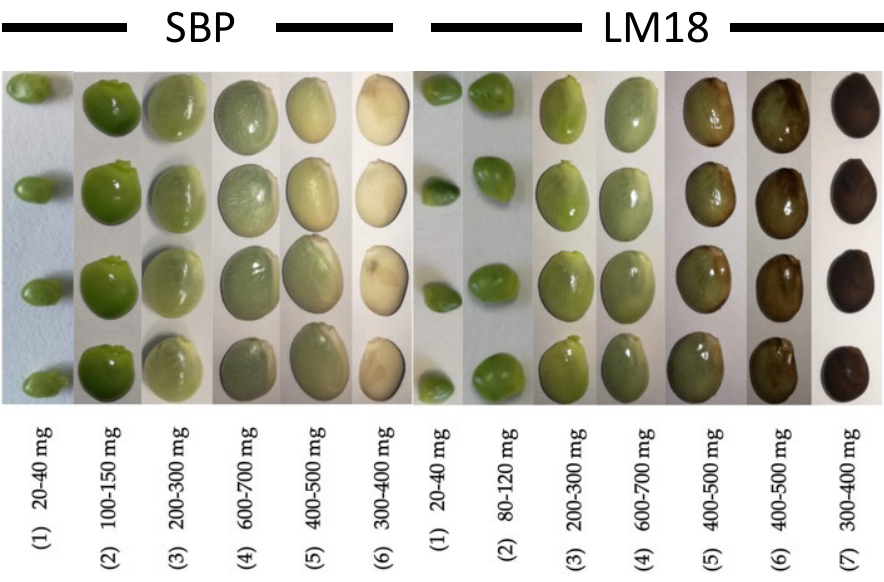
Figure 2. Seed development stages (1–6, with the corresponding fresh weight expressed in mg/seed) of Lupinus mutabilis accessions SBP (white seed; left) and LM18 (brown seed with dark-brown eyebrow; right) used for transcriptomic analysis.